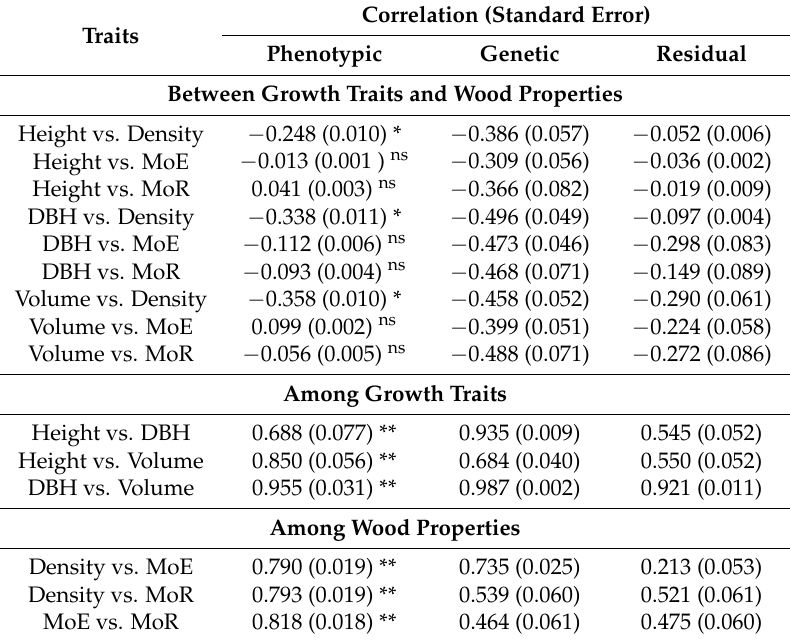
Table 2. Phenotypic, genetic and residual correlations between and among growth traits and wood